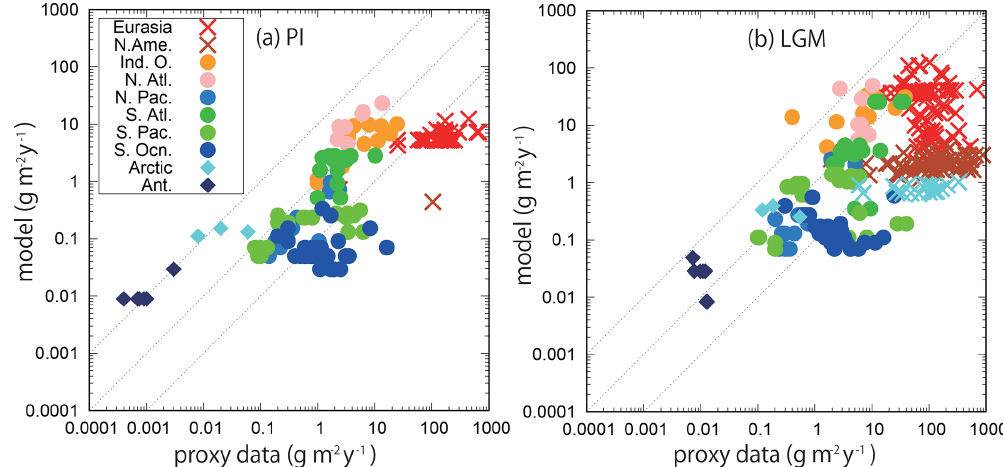
Figure 8. Dust deposition from model output and derived from proxy archives (Kohfeld et al., 2013; Albani et al., 2014) for (a) PI and (b) LGM (gm − 2 yr − 1 ). Colors represent the locations of the proxy data, as explained in the legend in the figure. Crosses, circles, and diamonds represent terrestrial, marine, and ice core data.